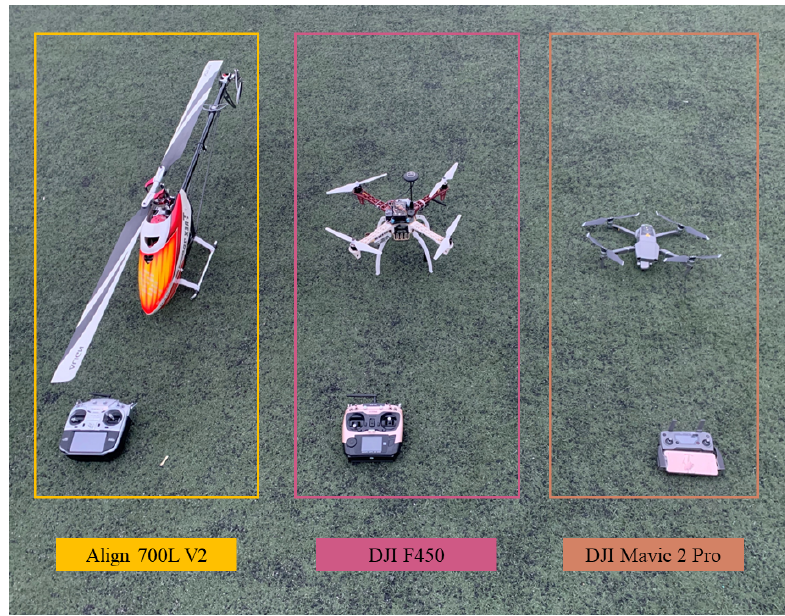
Figure 5. The three UAV obstacle objects.